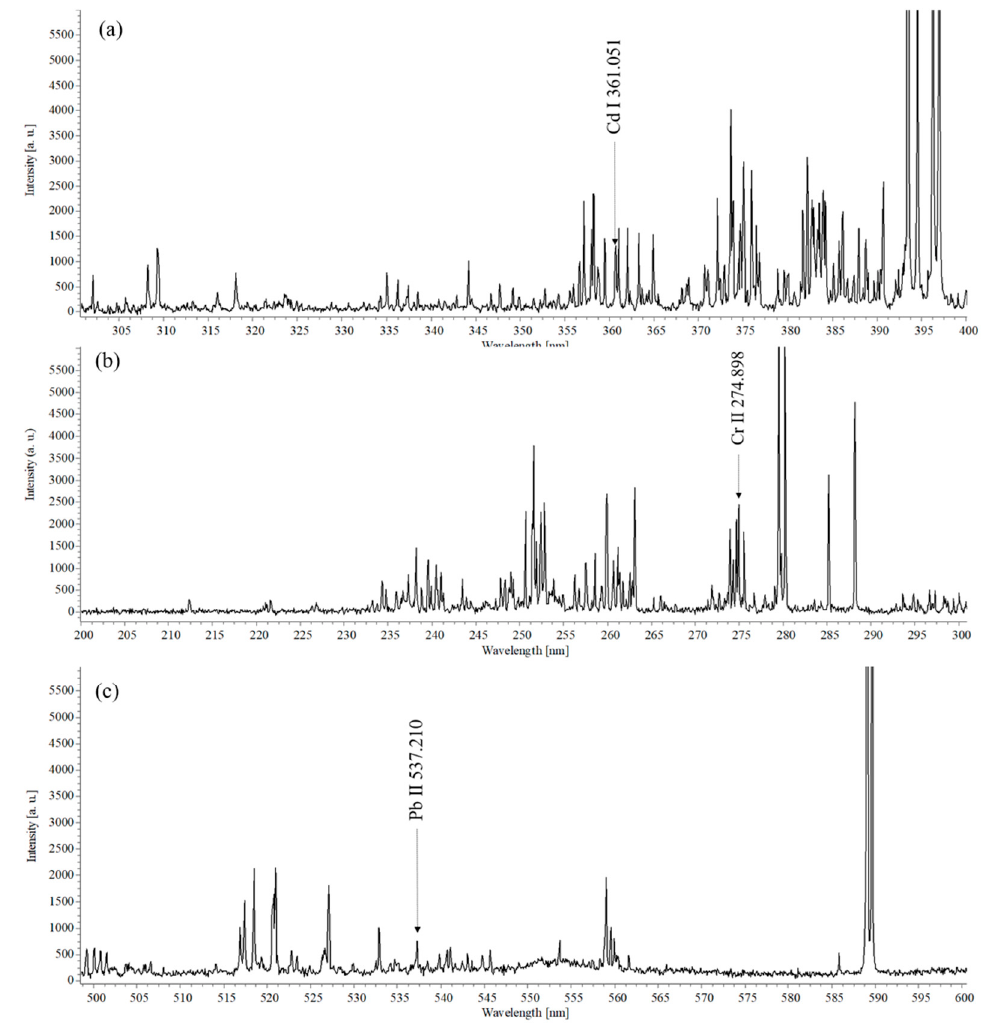
Figure 2. Main emission lines of the target elements (Cd, Cr, Pb) in the LIBS spectra of the sediment samples.